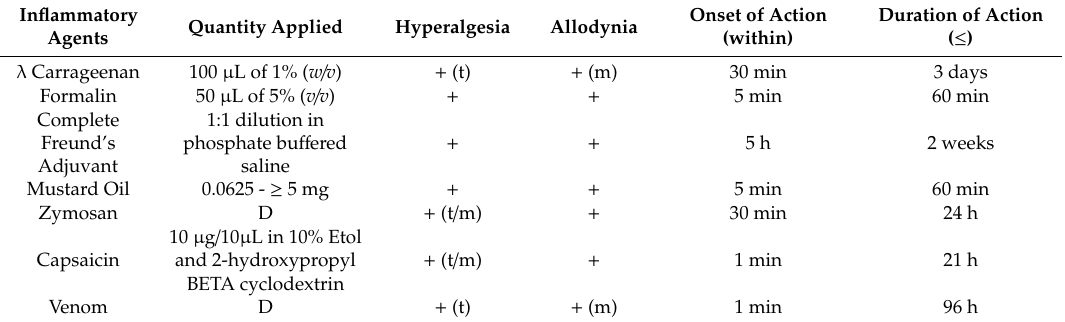
Table 2. The onset and duration of action elicited by di ff erent inflammatory agents and its sensitization caused.